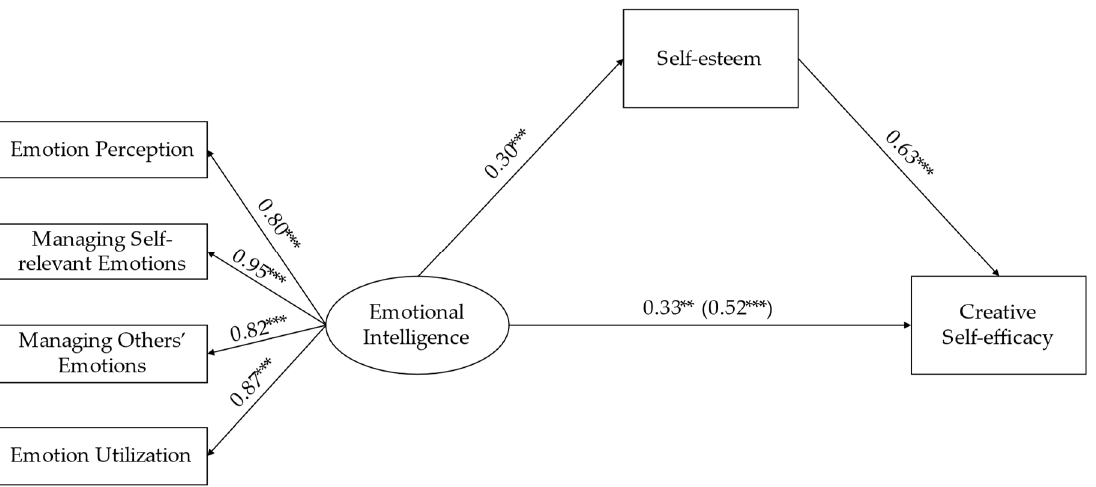
Figure 2. The mediating effect of self-esteem on the relationship between emotional intelligence and creative self-efficacy. ** p < .01, *** p < .001; The numbers are standardized regression coefficients. The residuals variances and controlled variable (age) in the model are not displayed.